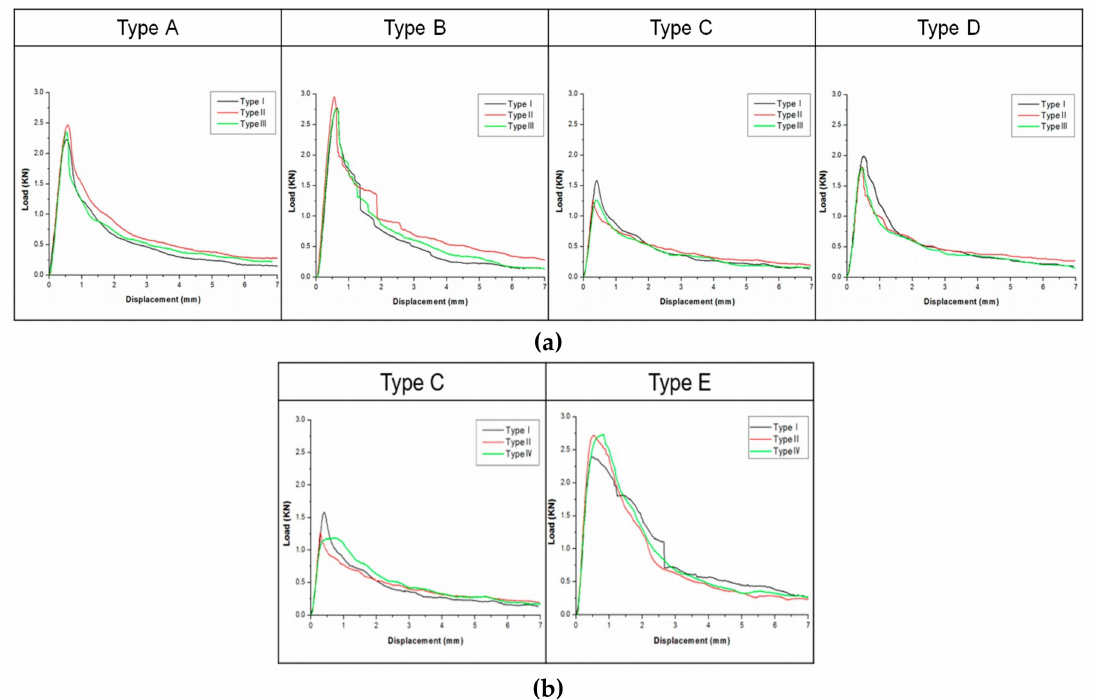
Figure 5. Load–displacement curves from the axial pullout test. ( a ) Type I, II, and III screws in Type A, B, C and D bone specimens, and ( b ) Type I, II, and IV screws in Type C and E bone